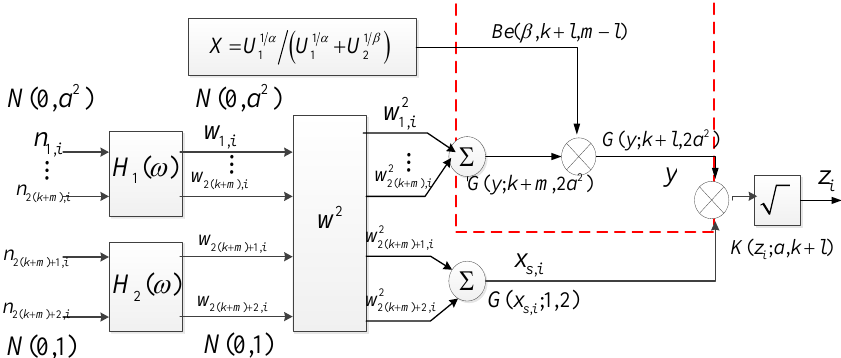
Figure 3. Flow diagram of the proposed improved method for generating correlated K-distributed clutter based on ZMNL.